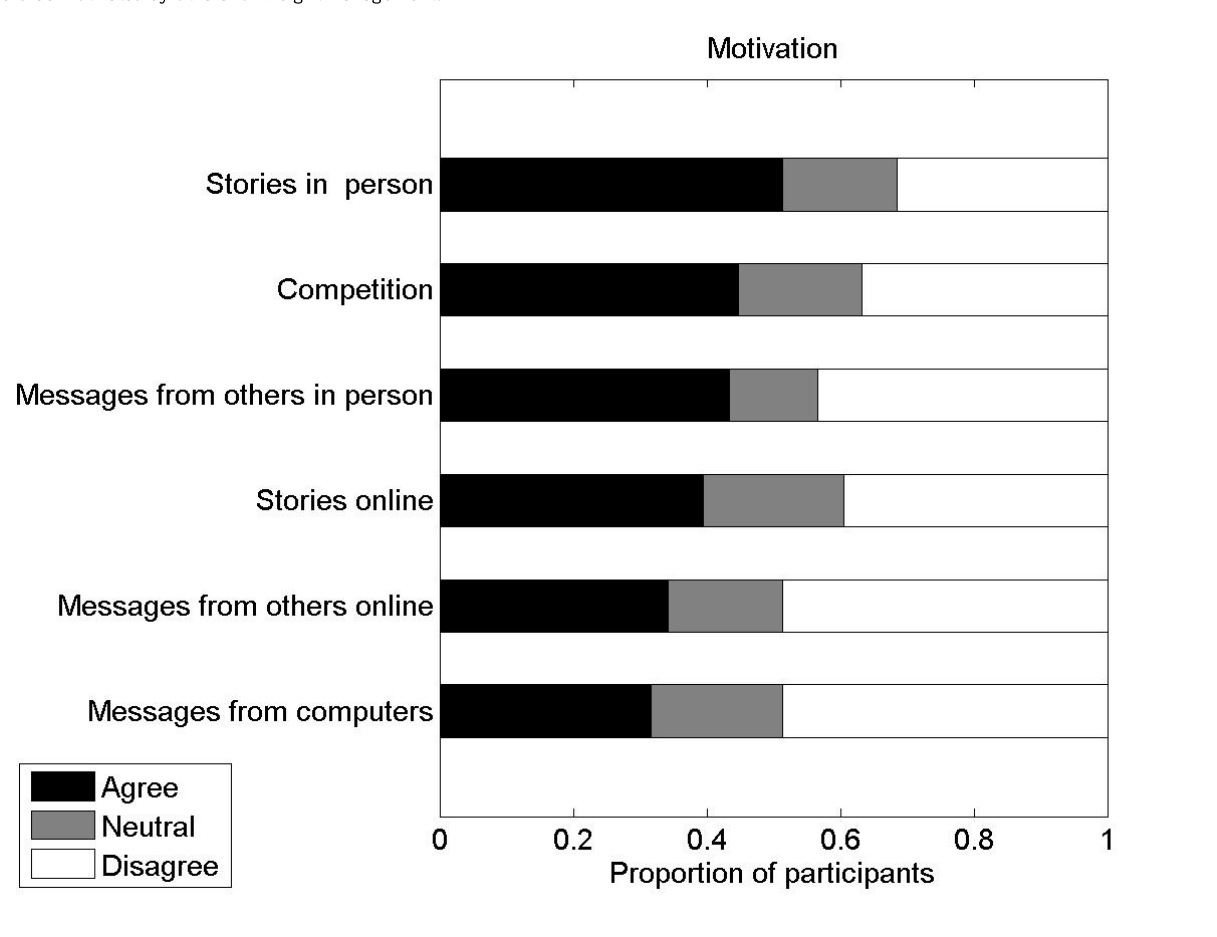
Figure 3. The proportion of respondents who agreed, were neutral, or disagreed with statements reflecting different ways and modes by which one could be motivated by others for weight